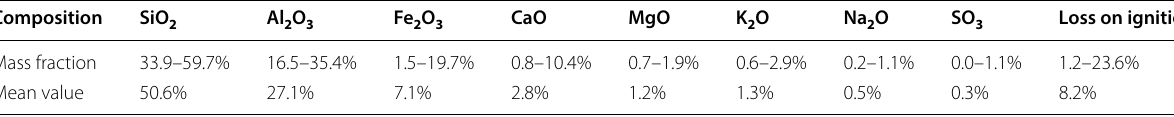
Table 4 Chemical compositions of fly ash from 31 representative thermal power stations in